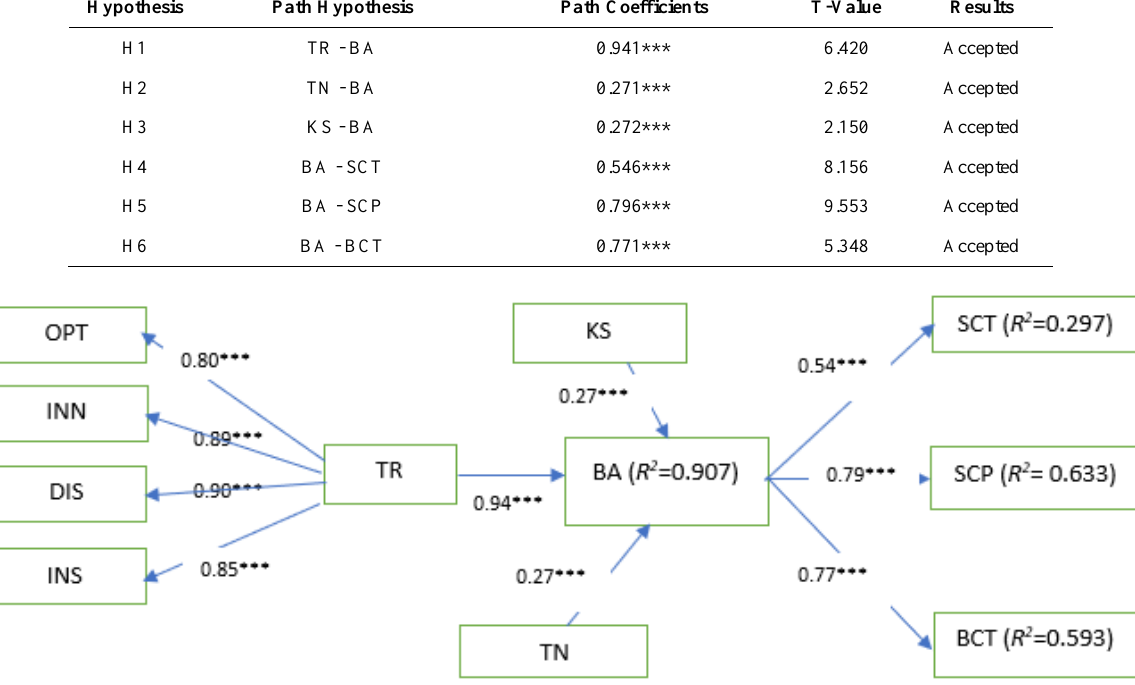
Figure 3. Results of path coefficients and hypothesis